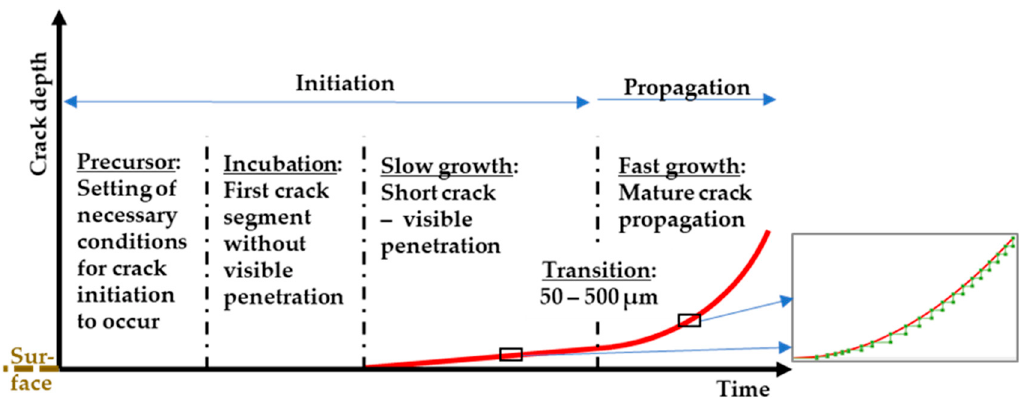
Figure 1. Scheme of environmentally assisted cracking (EAC) crack development from surface showing definition of the initiation, including the precursor, the incubation, and the slow growth, and the propagation stages; adapted based on Staehle [20].